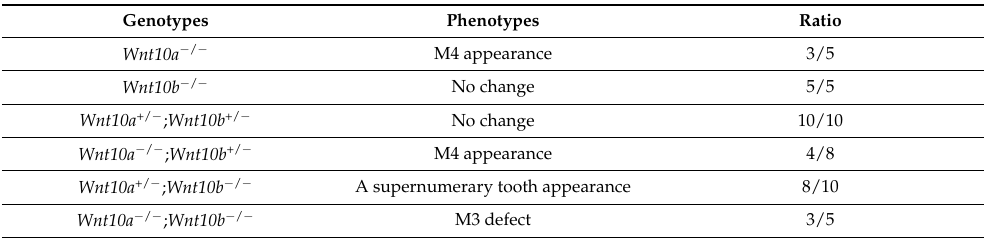
Figure 2. Representative tooth phenotypes in 4-week-old wild-type and mutant mice. μ CT analysis of maxillae ( A , C ) and mandibles ( B , D ) from wild-type (control), Wnt10a − / − , Wnt10b − / − , Wnt10a +/ − ; Wnt10b +/ − , Wnt10a − / − ; Wnt10b +/ − , Wnt10a +/ − ; Wnt10b − / − , and Wnt10a − / − ; Wnt10b − / − mice at 4 weeks. M1, first molar; M2, second molar; M3, third molar. The arrowhead and asterisk indicate a supernumerary tooth behind mandibular M3 and anterior to mandibular M1, respectively. Table 1. Tooth phenotypes of Wnt10a and Wnt10b mutant mice. Ratio means the frequencies of distinct phenotypes in each